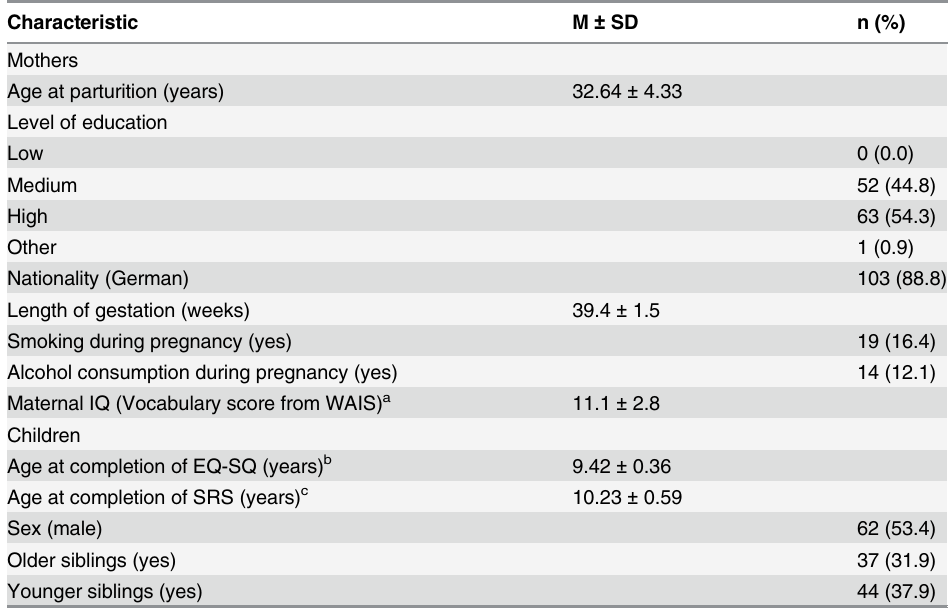
Table 1. Descriptive data of the follow-up sample (n =